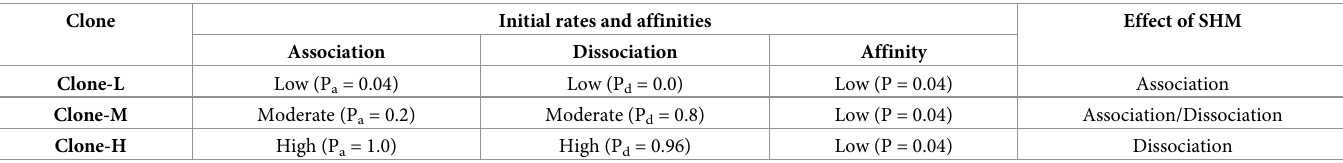
Table 1. Initial affinity, association and dissociation rates of founder clones. Clone Initial rates and affinities Effect of SHM Association Dissociation Affinity Clone-L Low (P a = 0.04) Low (P d = 0.0) Low (P = 0.04) Association Clone-M Moderate (P a = 0.2) Moderate (P d = 0.8) Low (P = 0.04) Association/Dissociation Clone-H High (P a = 1.0) High (P d = 0.96) Low (P = 0.04) Dissociation P a , P d and P represent probability of association, dissociation and affinity of CCs in the shape-space, respectively. The effect of SHM is different for each clone. For more detail, check the description of methods in section